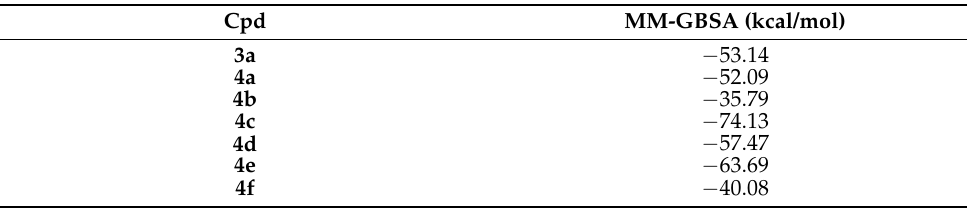
Table 3. MM-GBSA calculations for compounds 3a and 4a – f